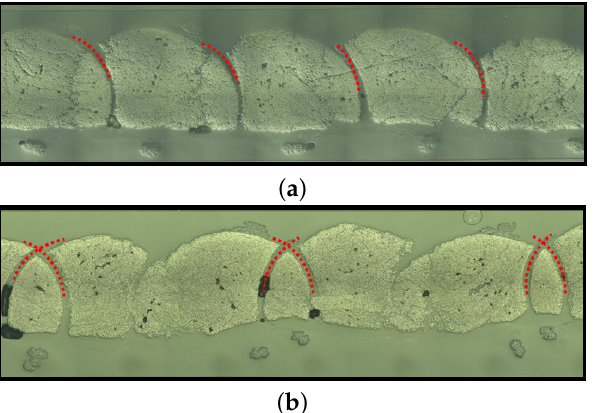
Figure 7. Micrography of the cross-section highlighting the ( a ) symmetric and ( b ) antisymmetric stitching.